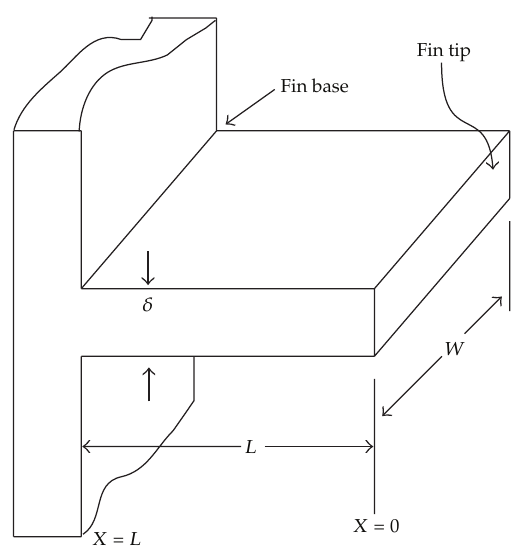
Figure 1: Schematic representation of a one-dimensional